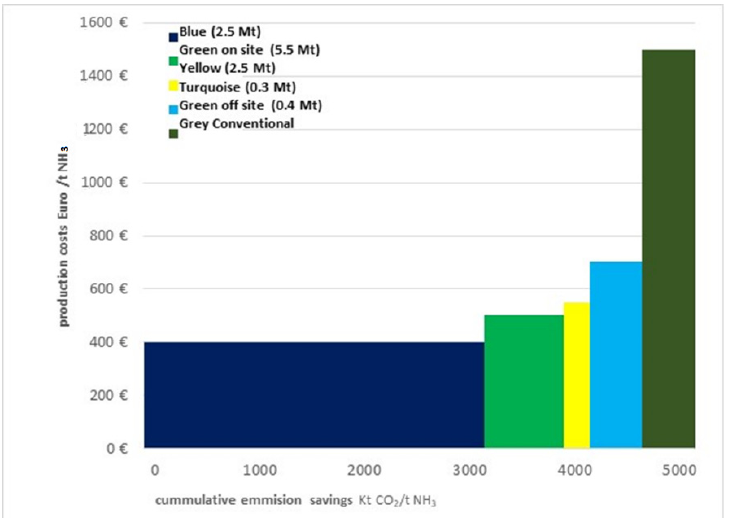
Figure 14. Comparison costs of different ammonia production pathways, including blue and green ammonia, based on the cumulative emission savings (Kt CO 2 /t NH 3 ). Reprinted with permission [76].